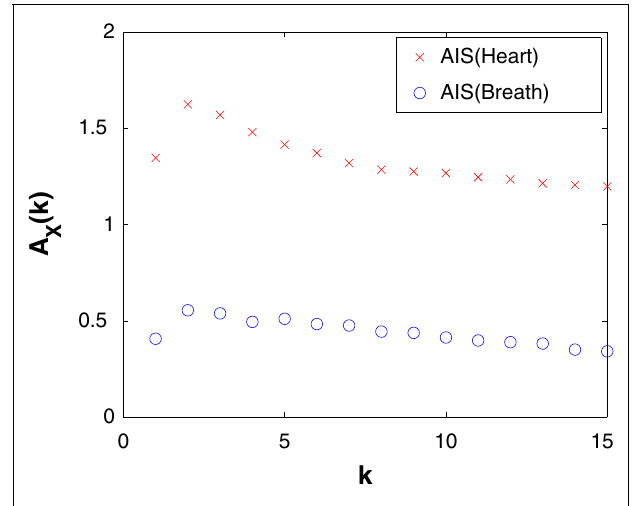
FIGURE 3 |Active information storage (AIS) computed by the KSG estimator ( K = 4 nearest neighbors) as a function of embedded history length k for the heart and breath rate time-series data